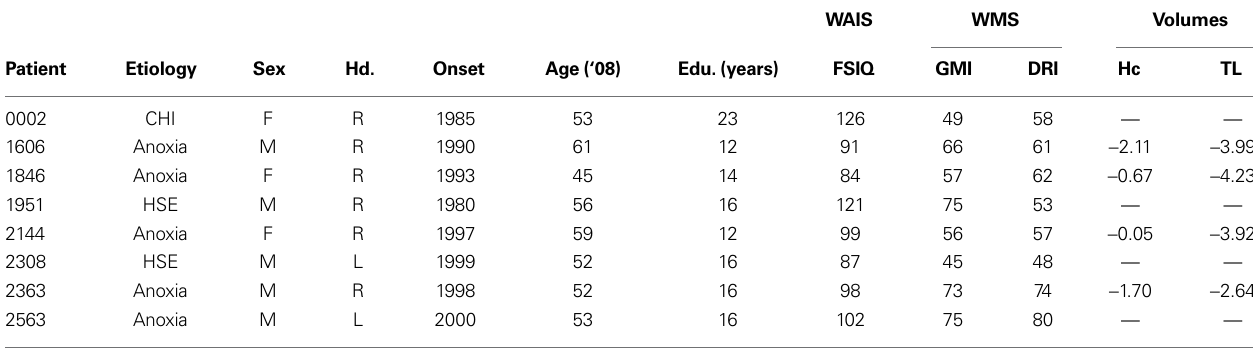
Table 1 | Details of participating neurological